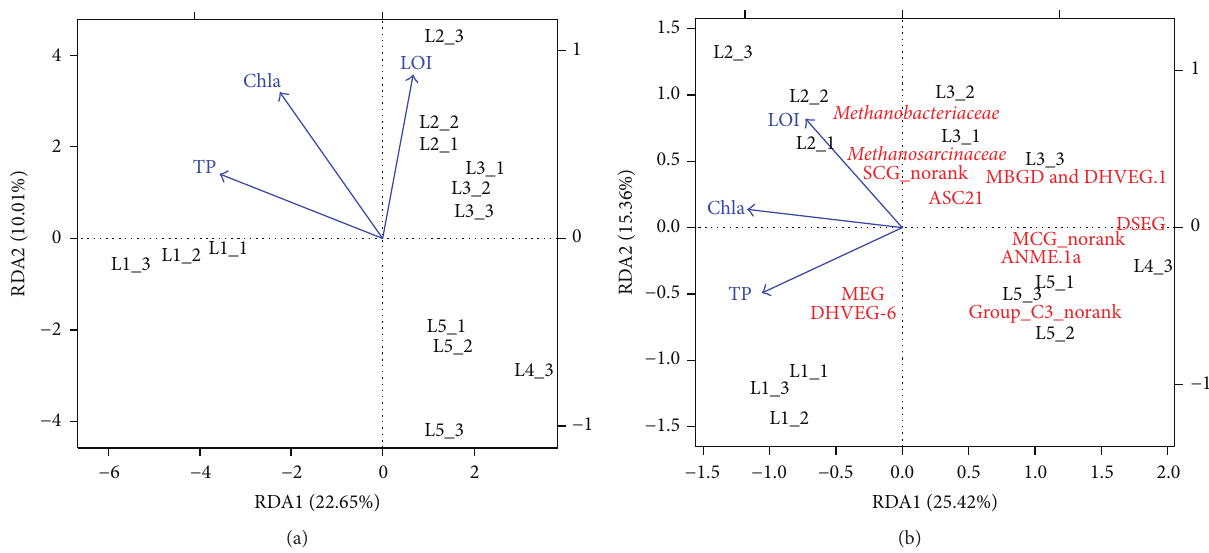
Figure 2: (a) The relationship of archaeal community composition among the five sediment layers with the major environmental factors at the OTU level. Redundancy analysis (RDA) plot was drawn by RDA1 and RDA2. (b) The most abundant 13 families were correlated with the major environmental factors (MCG: Miscellaneous Crenarchaeotic Group; DHVEG-6: Deep Sea Hydrothermal Vent Gp-6; MEG: Miscellaneous Euryarchaeotic Group; DSEG: Deep Sea Euryarchaeotic Group; MBGD: Marine Benthic Group D; ANME: anaerobic methanotroph).